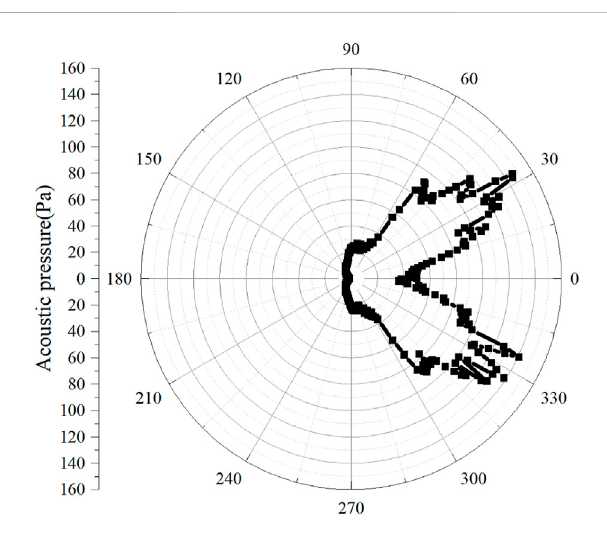
FIGURE 11 Acoustic results for the density-based Kirchhoff